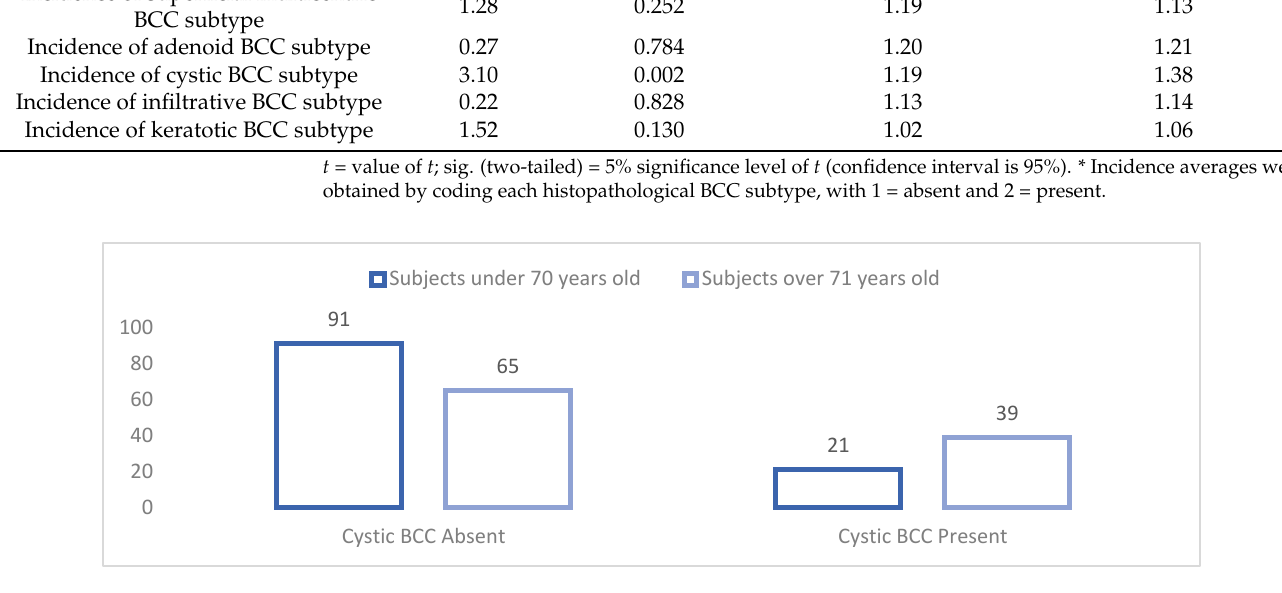
Figure 1. Significant differences between subjects under 70 years of age and over 71 years of age in the incidence of diagnosis with the cystic BCC subtype.